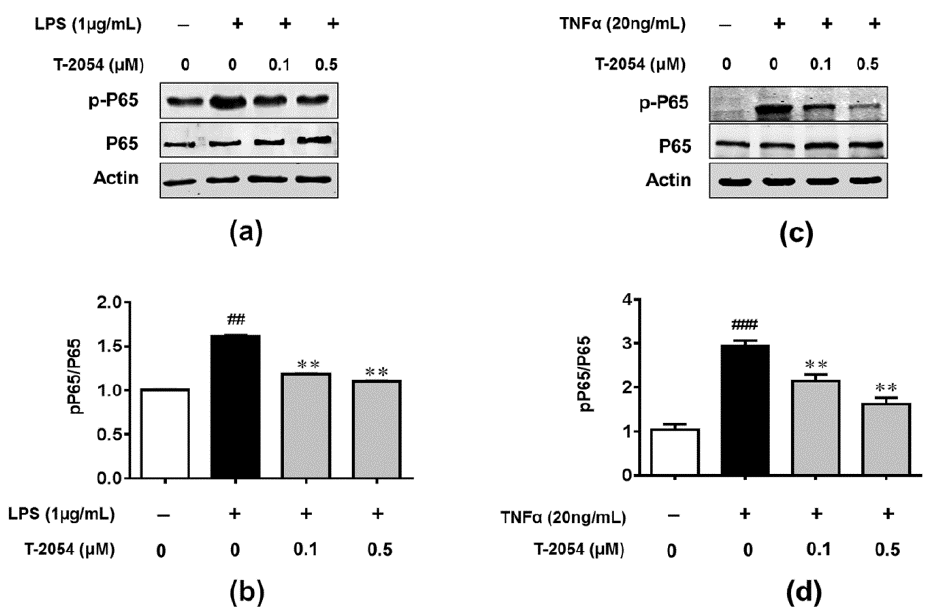
Figure 6. Detected phosphorylation level of NF- κ B p65 in RAW 264.7 cells and ATDC5 cells. The RAW 264.7 cells were treated with LPS (1 µ g/mL) 1 h later and treated with or without T-2054 for 30 min. Lysates were prepared, and Western blot was performed to detect the expression of p-P65, P65 and actin in LPS-induced RAW 264.7 cells ( a ). Histogram analysis of the levels of p-P65 and P65 ( b ). The ATDC5 cells were treated with TNF- α (20 ng/mL) 1 h later and treated with or without T-2054 for 30 min. Lysates were prepared, and Western blot was performed to detect the expression of p-P65 and P65 in TNF- α -induced ATDC5 cells ( c ). Histogram analysis of the levels of p-P65 and P65 ( d ). Actin was used as an internal control. Each value represents the mean ± SD, performed in 3 different experiments. ## p < 0.01, ### p < 0.001 vs. CON group; ** p < 0.01 vs. Stimulate group.